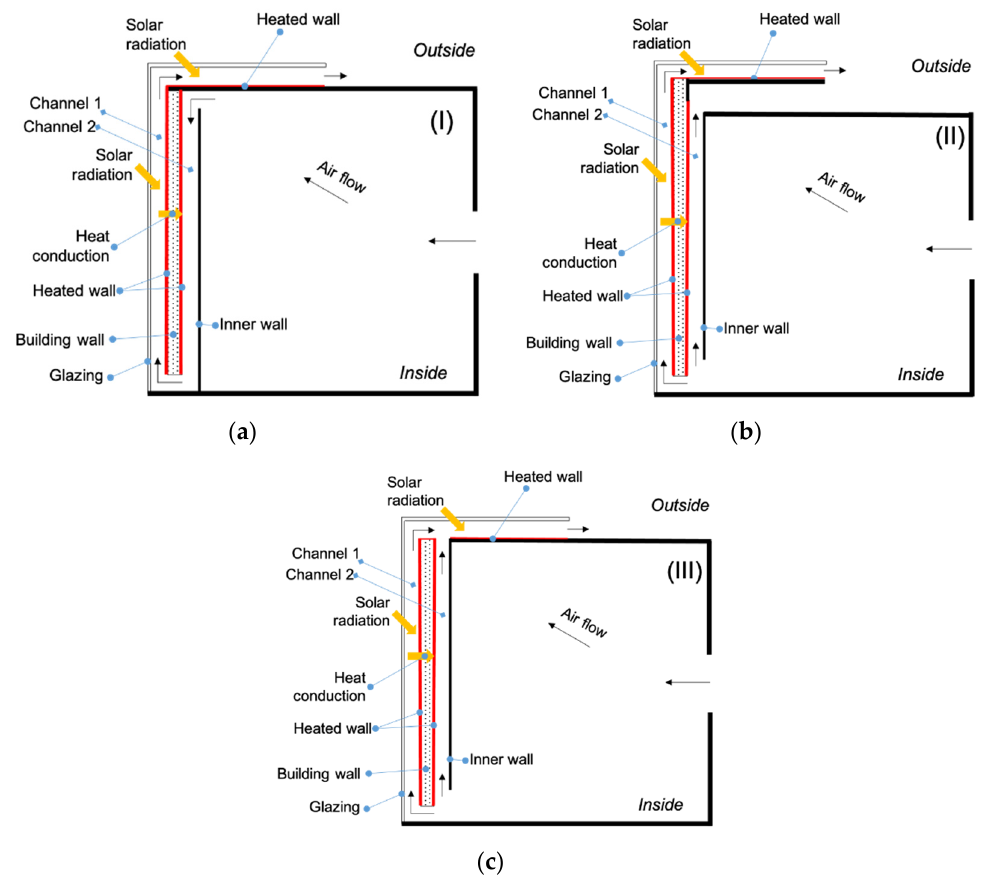
Figure 1. The proposed system: ( a ) Configuration (I), ( b ) Configuration (II), and ( c ) Configuration (III).